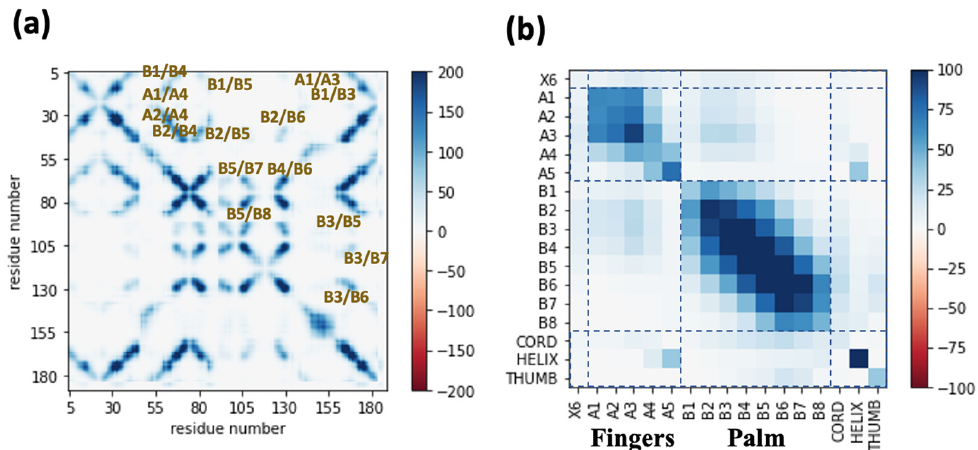
Figure 3. ( a ) Communicability matrix of the WT-X6 complex showing the non-adjacent regions, and ( b ) region-wise communicability of the WT-X6 complex displaying the communicability between pairs of local segments with defined secondary structure and the X6 substrate.